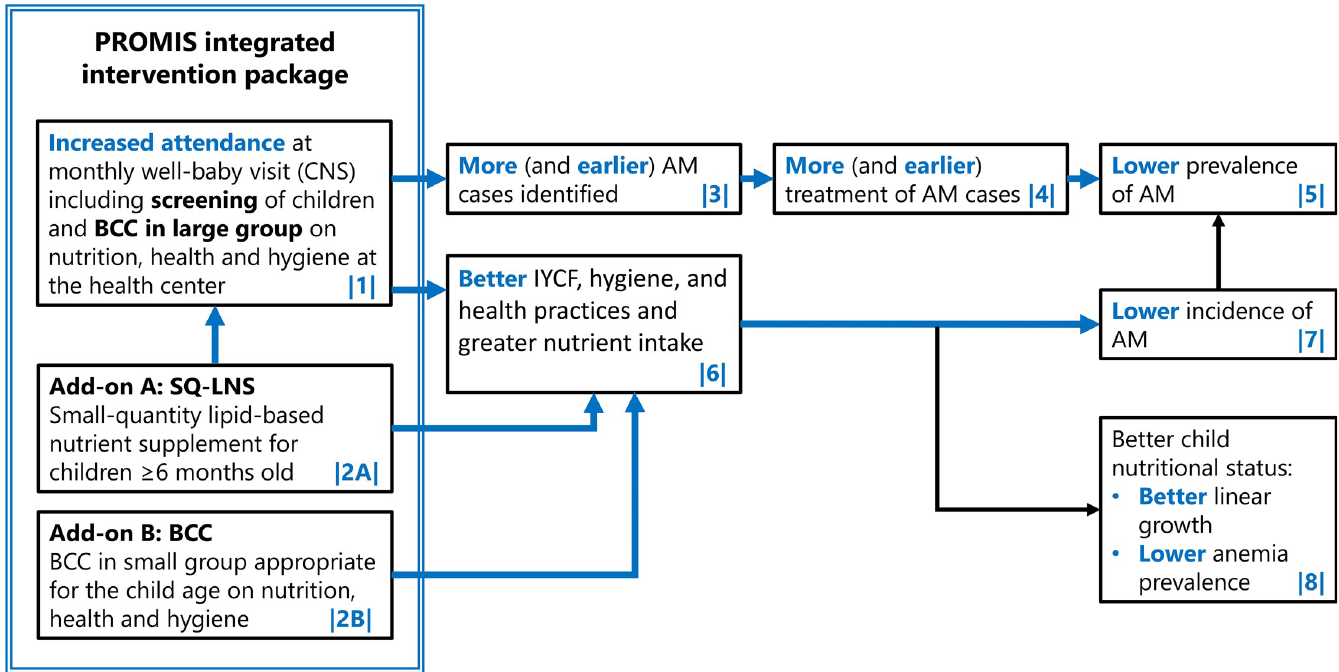
Fig 1. Theory of change of the integration of a preventive package at the well-baby visit. Hypothesized impacts of the intervention presented in this paper are shown in blue. AM, acute malnutrition; BCC, behavior change communication; IYCF, infant and young child feeding; PROMIS, Innovative Approaches for the Prevention of Childhood Undernutrition; SN-LNS, small-quantity lipid-based nutrition supplement.